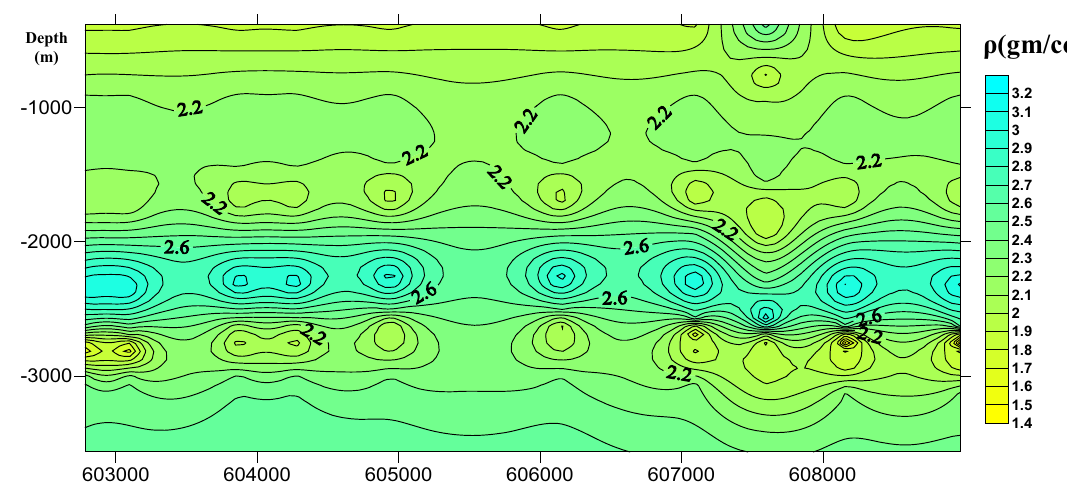
Fig. 11 2D interval velocity model along inline 10235